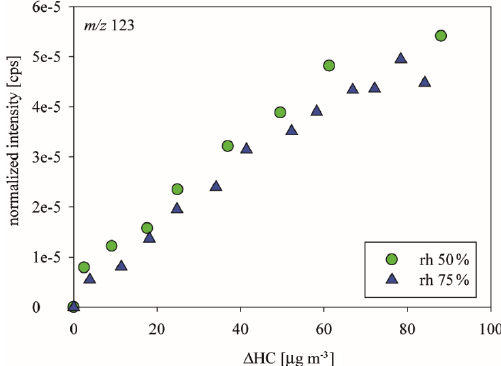
Figure 3. Evolution of m/z 123 as a function of consumption of m -cresol ( (cid:49) HC). The signal at m/z 123 can be attributed to methyl-